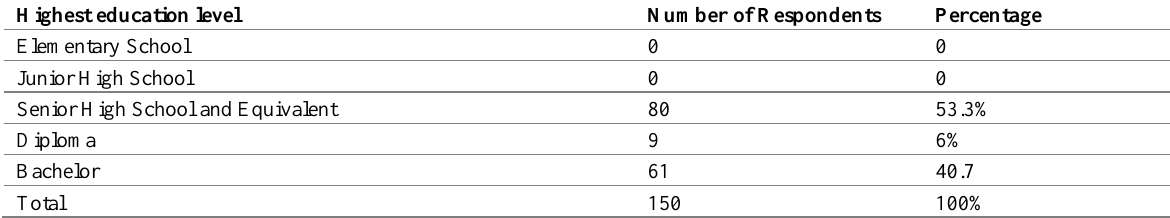
Table 6: Characteristics of Respondents by Highest Education Level